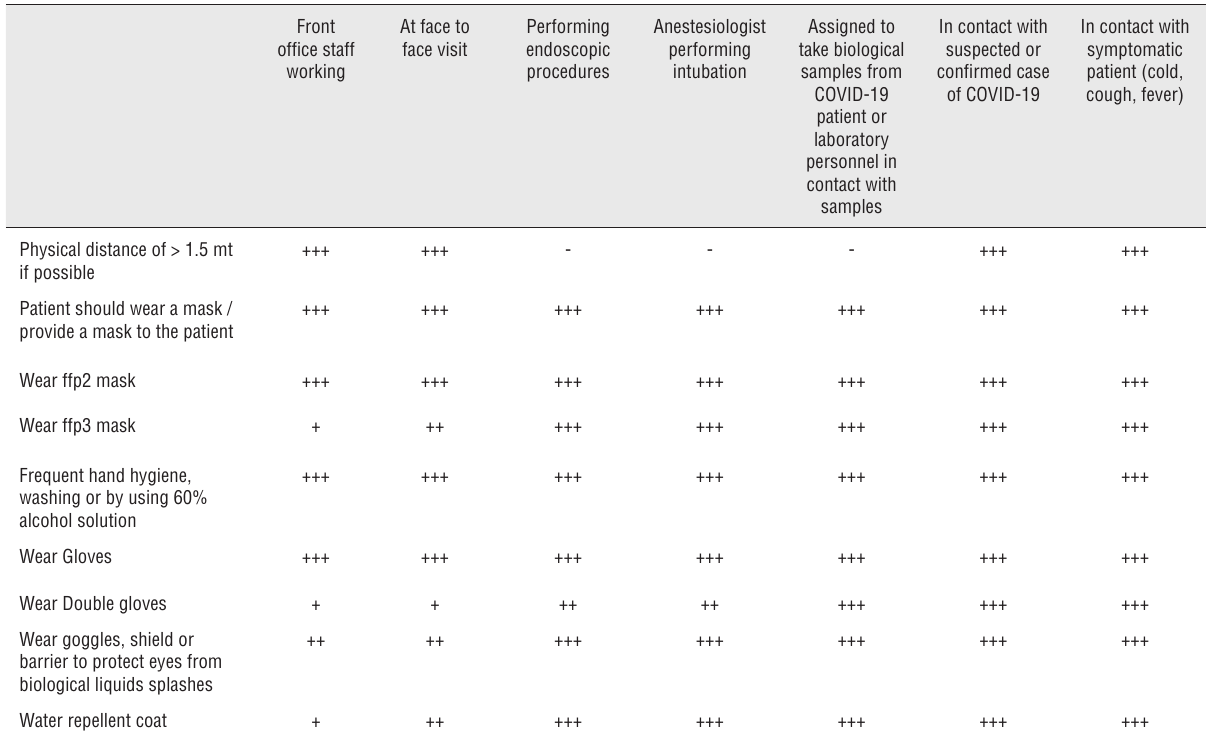
Table 1. Personal Protective Equipment (PPE) recommended for health professionals, in contact with patients during covid-19